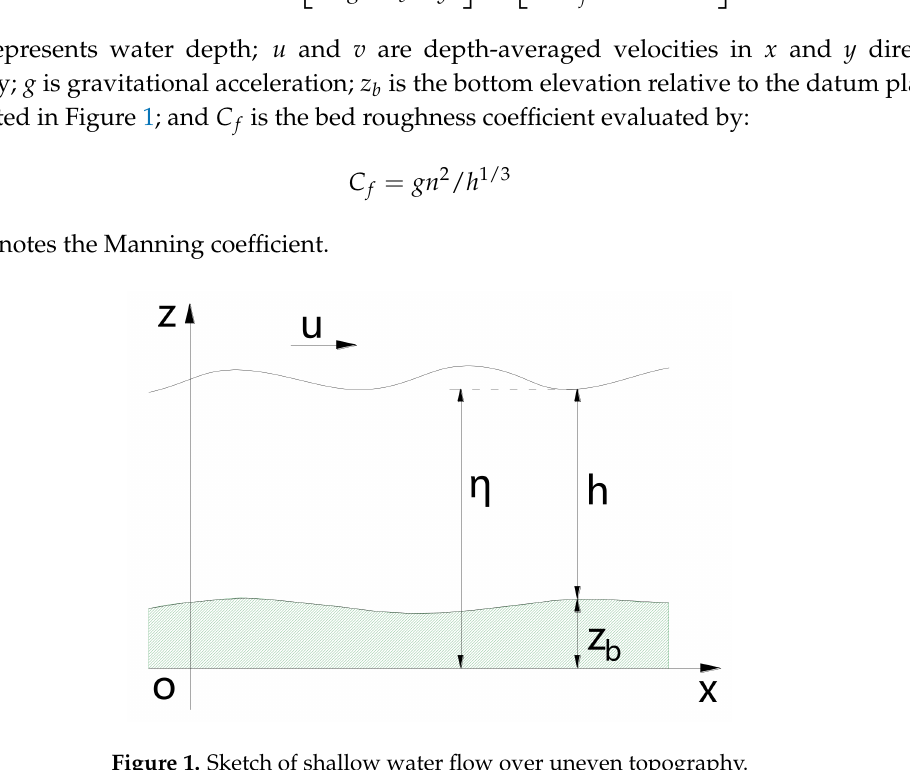
Figure 1. Sketch of shallow water flow over uneven